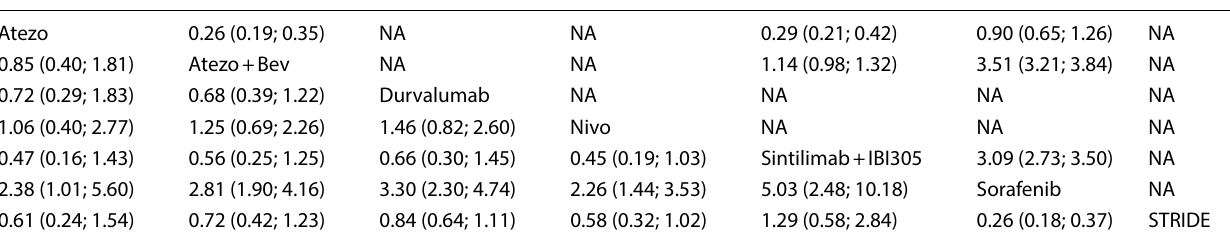
Table 4 Results of network